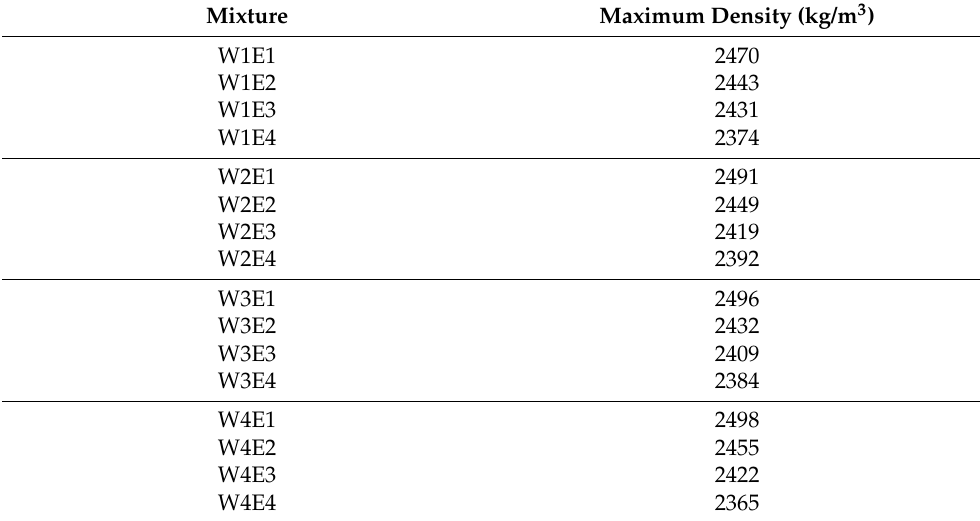
Table 3. Maximum density of the mixtures studied.